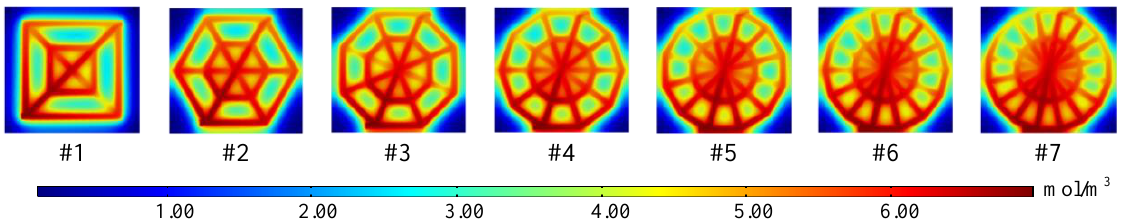
Figure 6. The oxygen distribution of schemes #1 to #7 at the interface of the cathode GDL and CL.